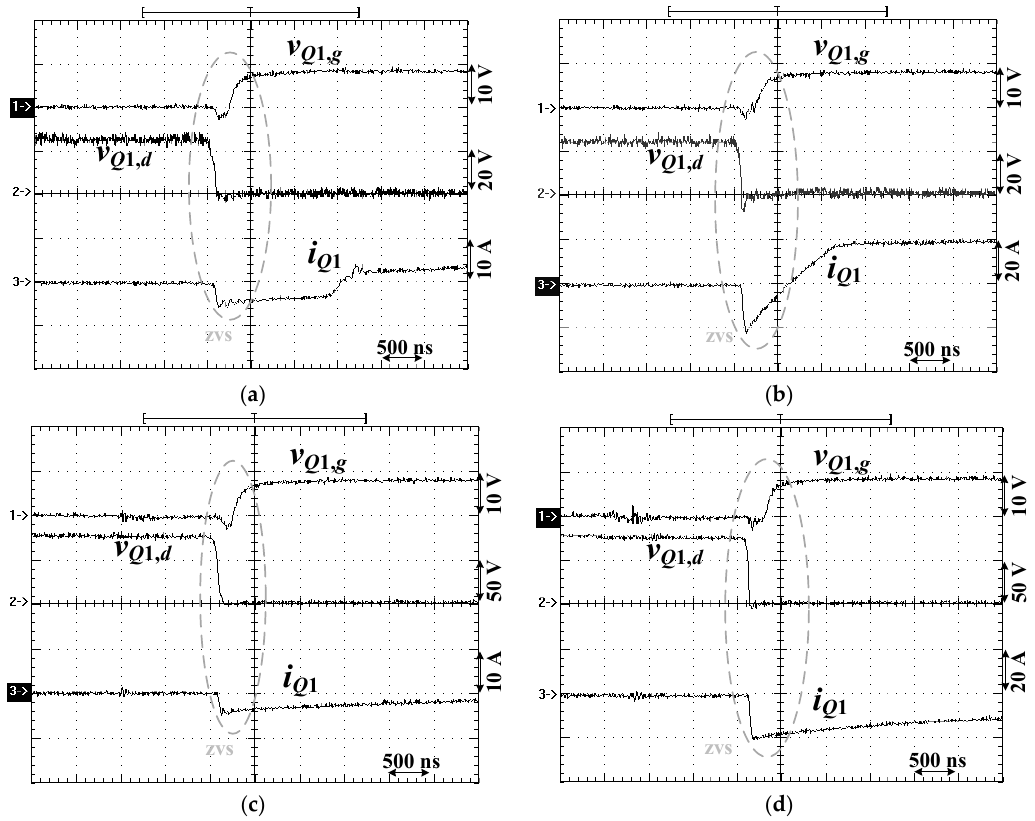
Figure 8. Experimental waveforms of the leading-leg switch Q 1 in low input voltage range at ( a ) 25 V input and 20% load ( b ) 25 V input and 100% load ( c ) 75 V input and 20% load ( d ) 75 V input and 100% load.